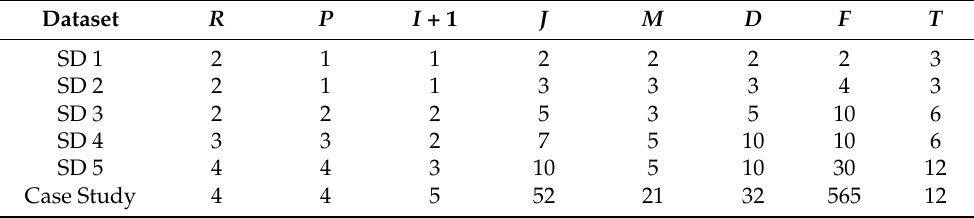
Table 14. PFSCM test